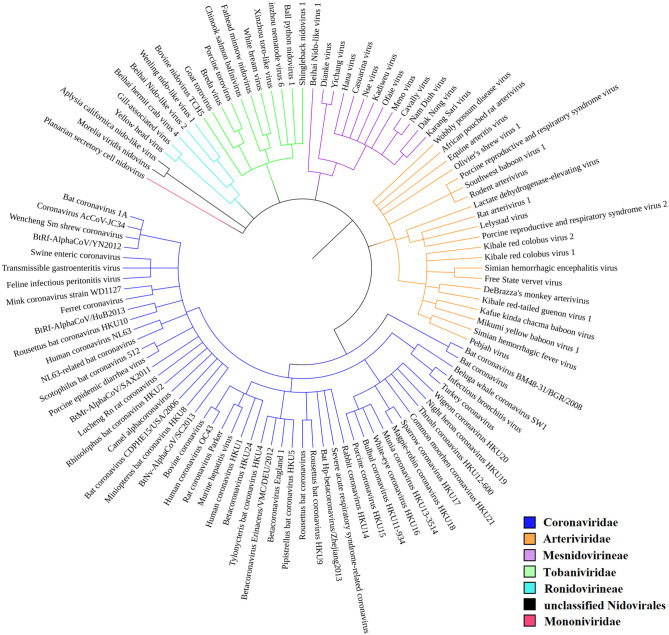
Phylogenetic relationships in Nidovirales. SARS-CoV-2 is not yet recognized by iToL, but, based upon current evidence, it probably will be placed close to the Bat Hp-betacoronavirus/Zheijang2013 and Severe acute respiratory syndrome-related coronavirus (SARS-nCoV) branches (Lu et al., 2020).